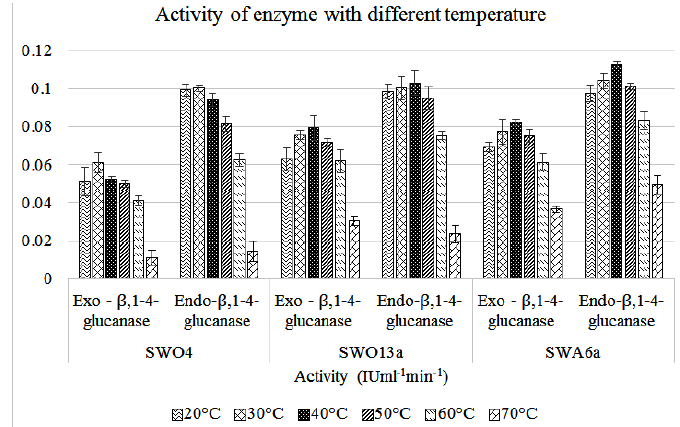
Fig. 2. Graphical representation of the variation of activity of Endo– β – 1,4 glucanase and Exo– β – 1,4 glucanase of the three Strains with varying Temperature ranging from 20°C - 70°C